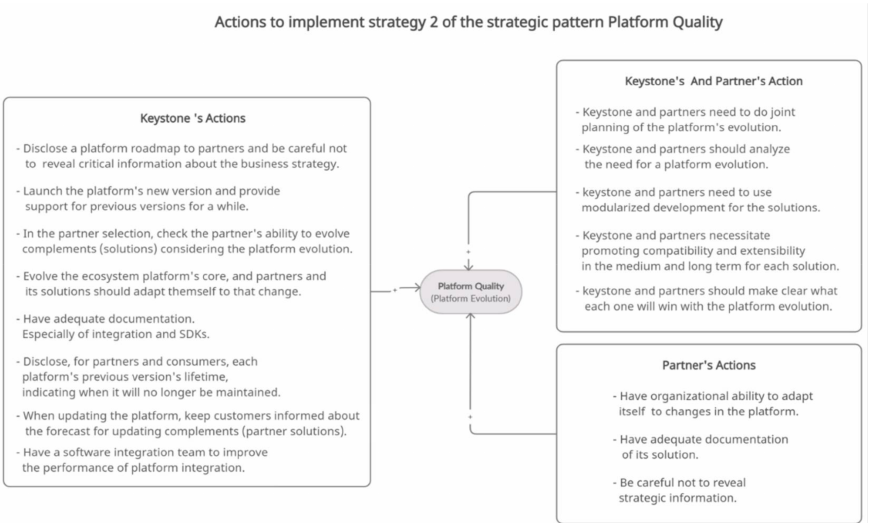
Figure 9. Result of the analysis of the interviews about the quality of the platform: actions that positively impact the platform quality (platform